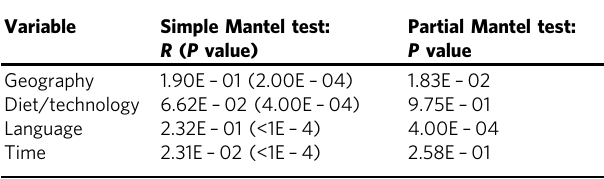
Table 1 Correlation of genetic distances with relevant